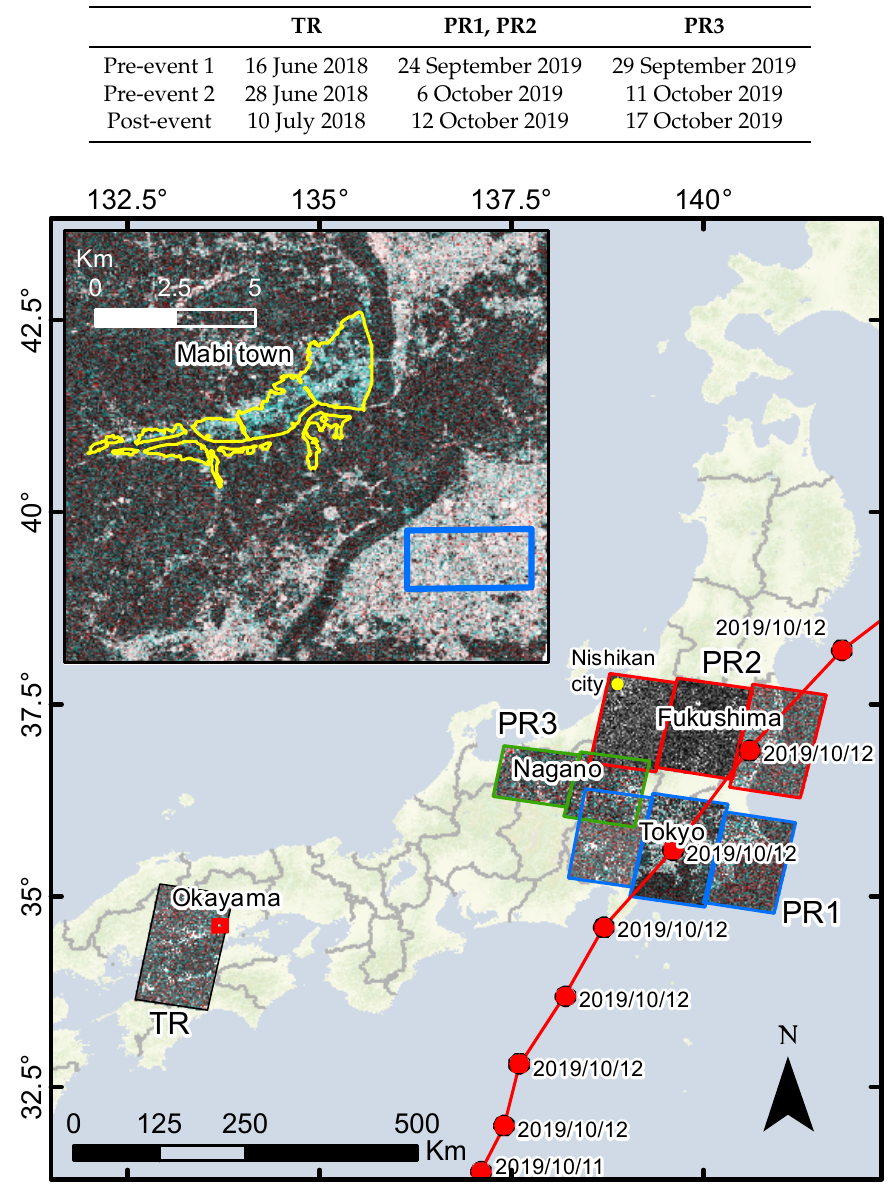
Figure 1. RGB color composite of co-event (R) and pre-event (G and B) coherence images. PR1, PR2, and PR3 are the areas where the predictions of floods associated with the 2019 Hagibis typhoon are intended. The yellow mark within PR2 denotes the location of the city of Nishikan, Niigata Prefecture. TR denotes the area associated with the 2018 western Japan floods, from which the training data is collected. The inset denotes a close-up of the flooded area in the town of Mabi, Okayama Prefecture. The yellow polygon indicates the extension of the flooded area. The blue rectangle is an instance of a non-flooded urban